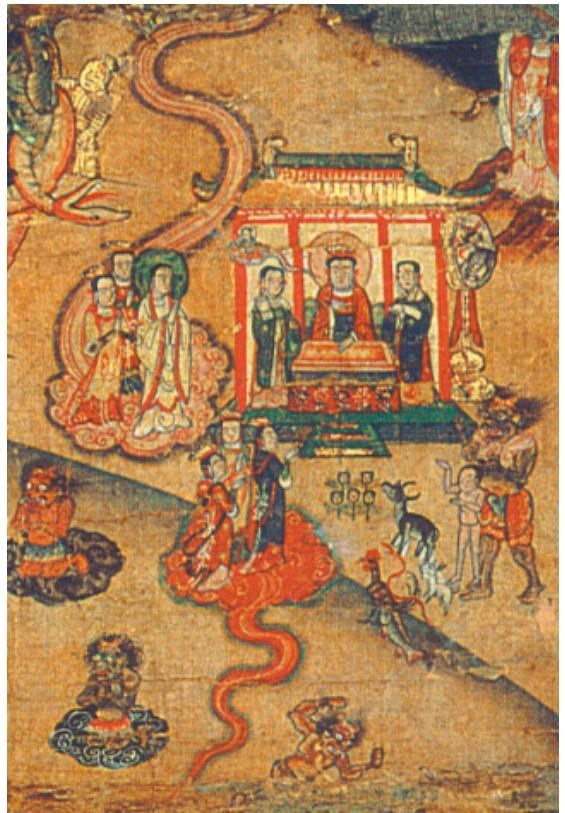
Figure 11. The judgment scene (Yoshida and Furukawa 2015, Plate 6).